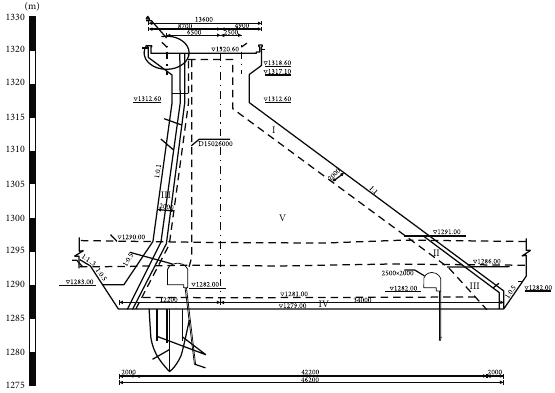
Figure 1: Standard cross-section of retaining dam section.